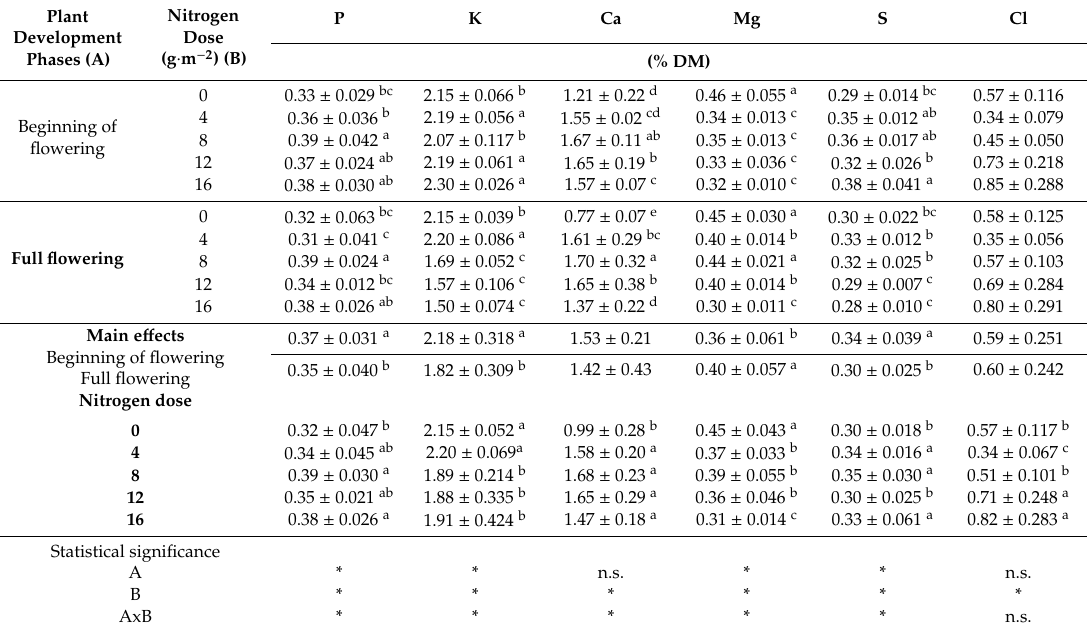
Table 2. E ff ect of the nitrogen dose and plant development phases on the chemical composition of summer savory herb (in 2014–2016) (Note: For an explanation, see Table